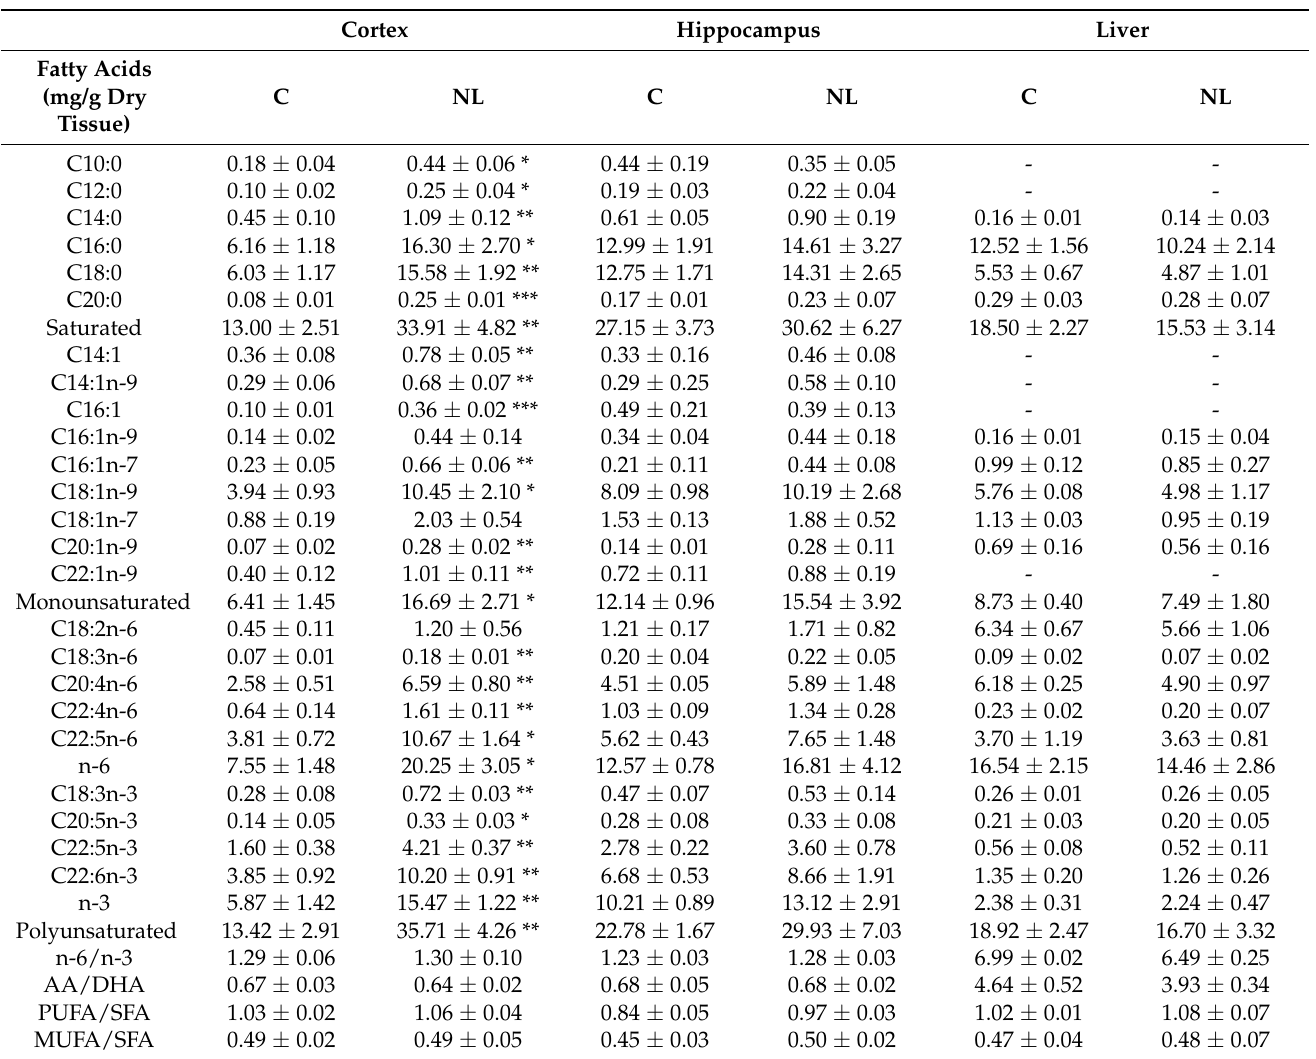
Table 3. Fatty acid composition in the cortex, hippocampus, and liver of mice after 8-week NL treatment. The values are expressed as the mean ± SD. Statistical differences between the control and nanoliposome groups for each fatty acid are shown for each tissue (* p < 0.05, ** p < 0.01, *** p < 0.001). Cortex Hippocampus